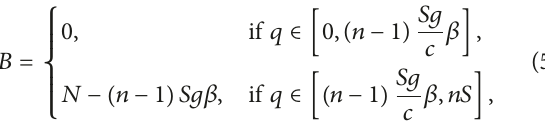
One should note that the computation of the 𝑑 2 distance at the DI is different from the case of the UI, for two